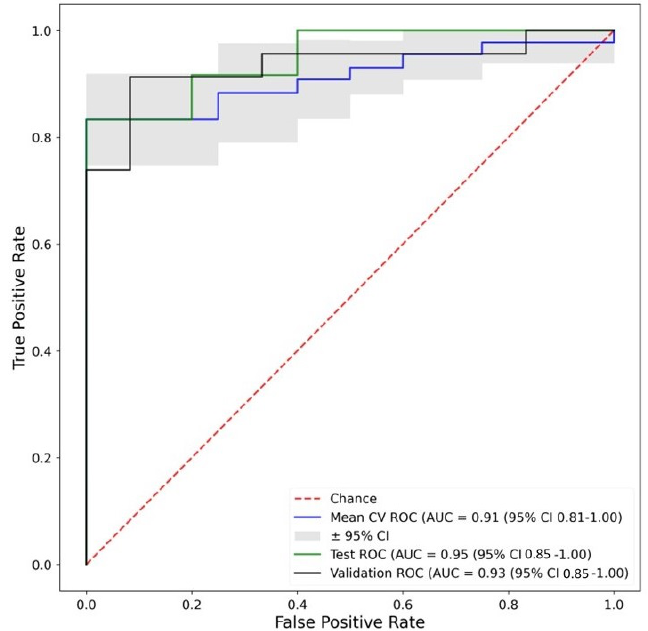
Figure 9. ROC curves of the Random Forest classifier in Fingerprint C. Corresponding Accuracies— Training: 0.79 , Test: 0.8, Validation: 0.73. Key: Mean CV ROC—Mean cross validation ROC from training dataset, Test ROC—ROC from test dataset, Validation ROC—ROC from validation